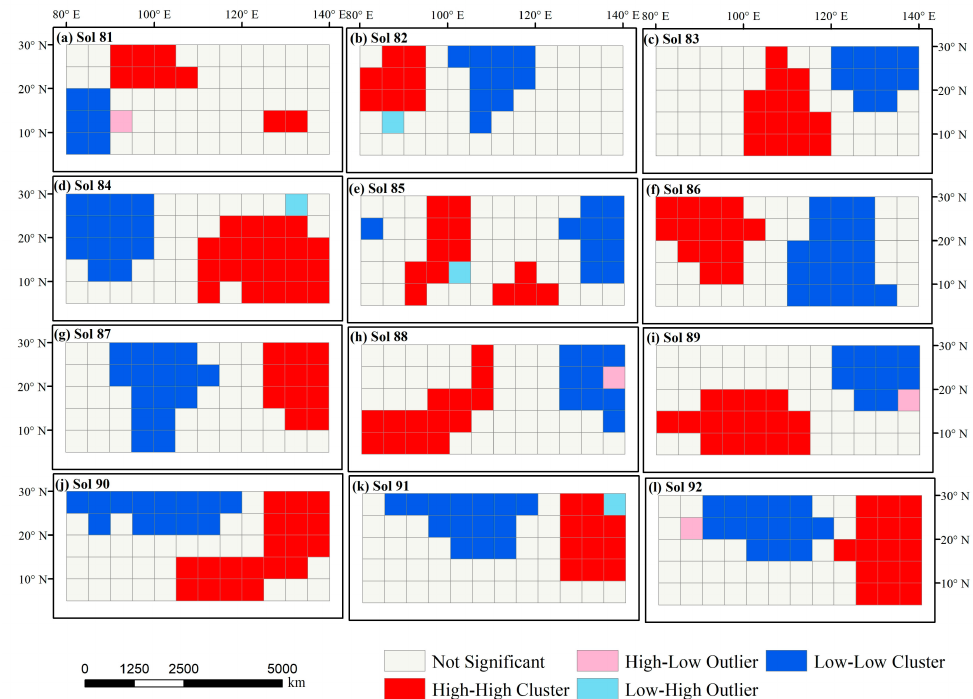
Figure 8. LISA for sol-to-sol temperature change (STC) during sol 81–92 in Martian year 29. The LISA maps for STC during sol 81–111 from Martian years 29 to 32 are in the Supplementary Materials (Figures